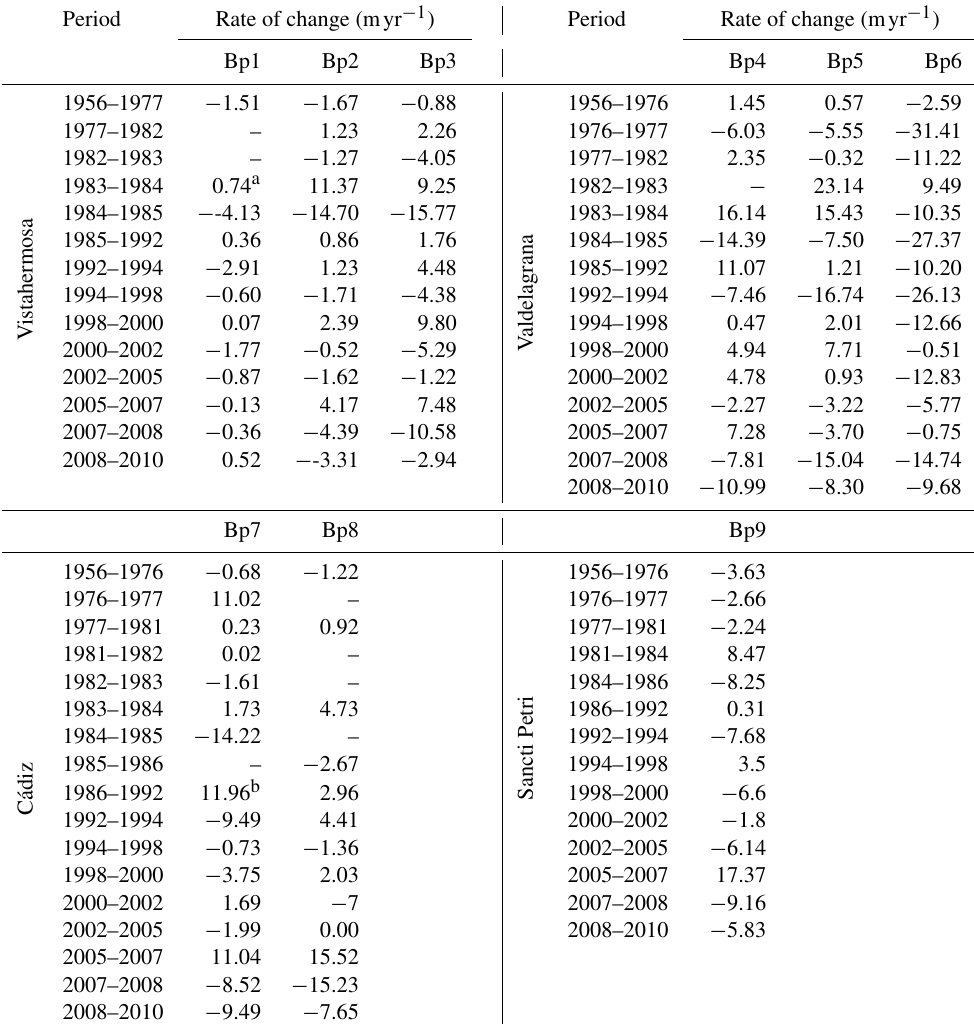
Table 3. Shoreline changes in the study area ( a rate for the period 1982–1984; b rate for the period 1985–1992; c rate for the period 1956– 1977; d rate for the period 1981–1984; e rate for the period 1984–1986 since certain aerial photographs were not available for these areas).